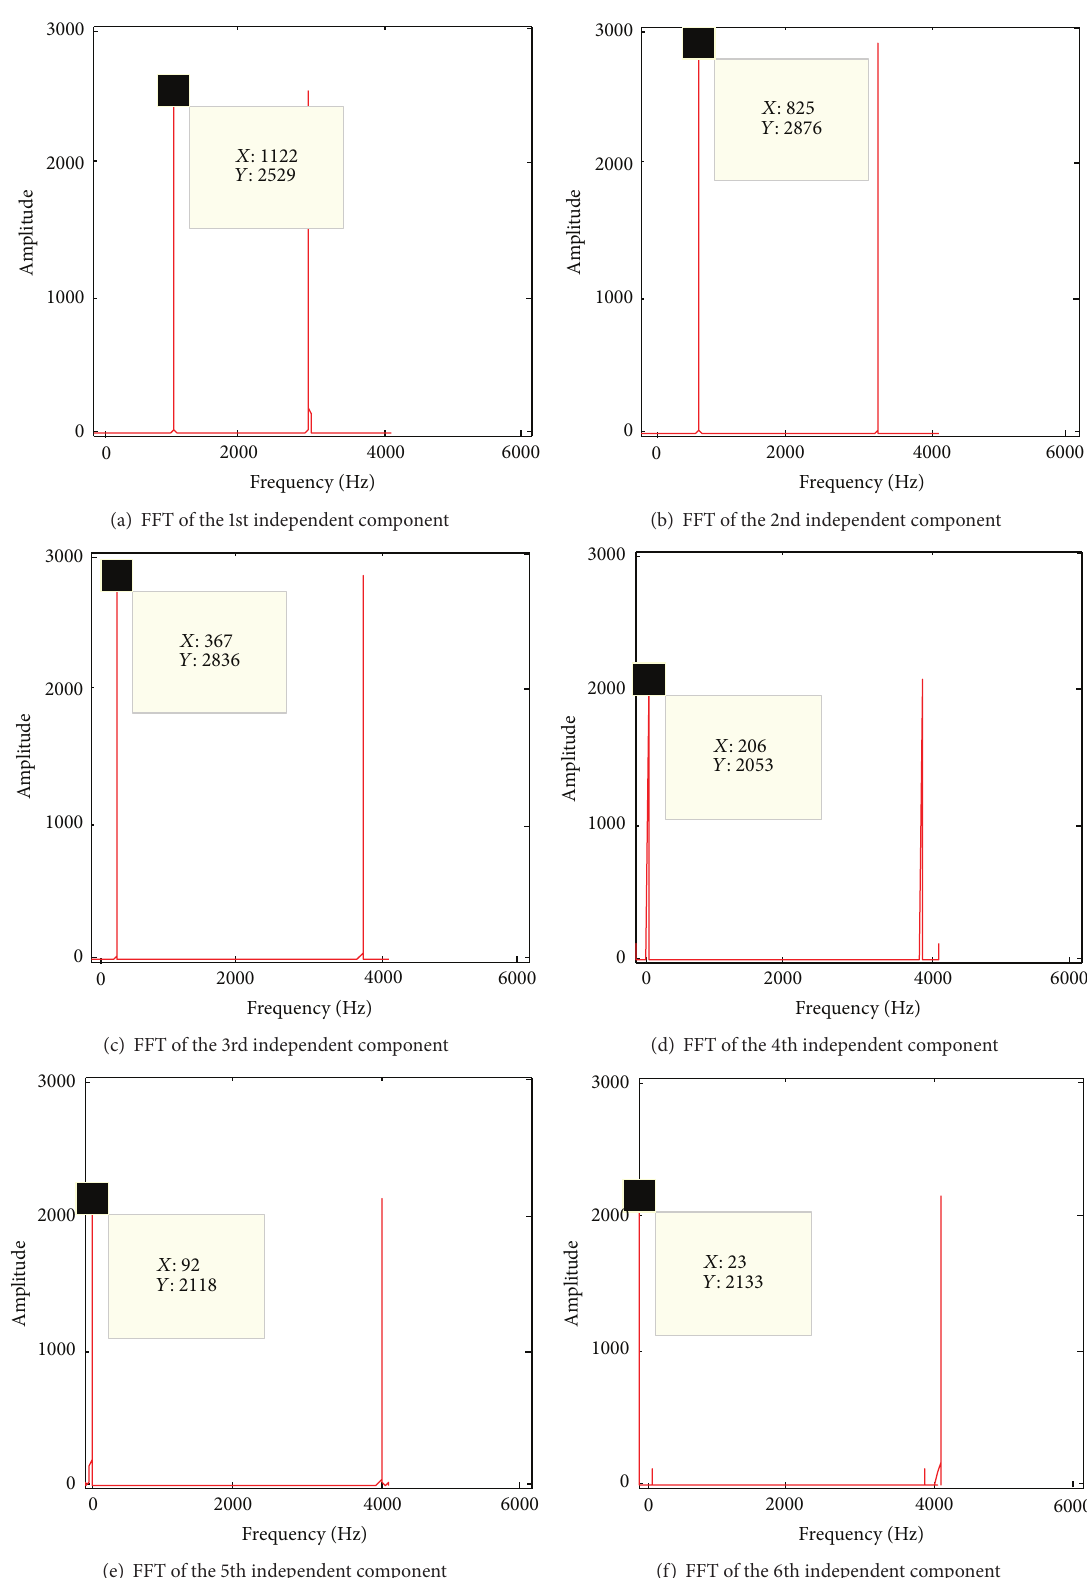
Figure 7: FFT of each independent component identified by minimum mutual information with gradient descent